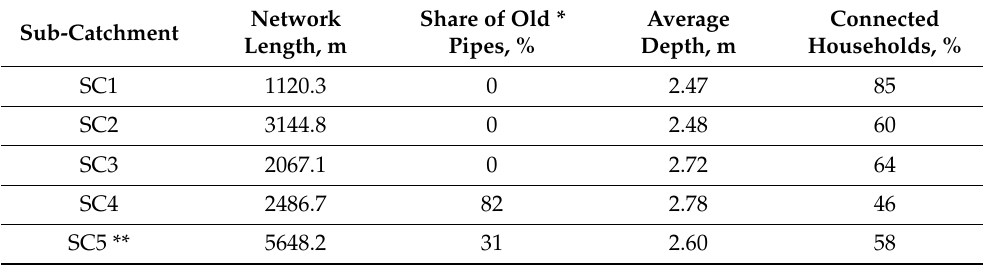
Table 1. Characteristics of the sub-catchments.